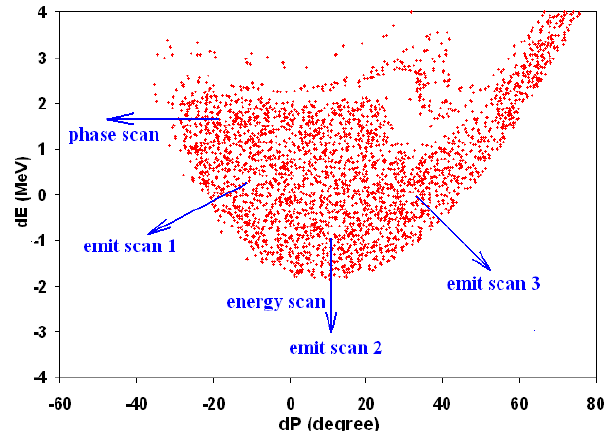
FIG. 10. (Color) Model of the longitudinal acceptance at the second SCL cavity with a 450 MeV allowance for the output energy error. The diffuse upper boundary of the acceptance is not appropriate for beam profile measurement. The blue arrows show paths used for phase, energy, and emittance measurement